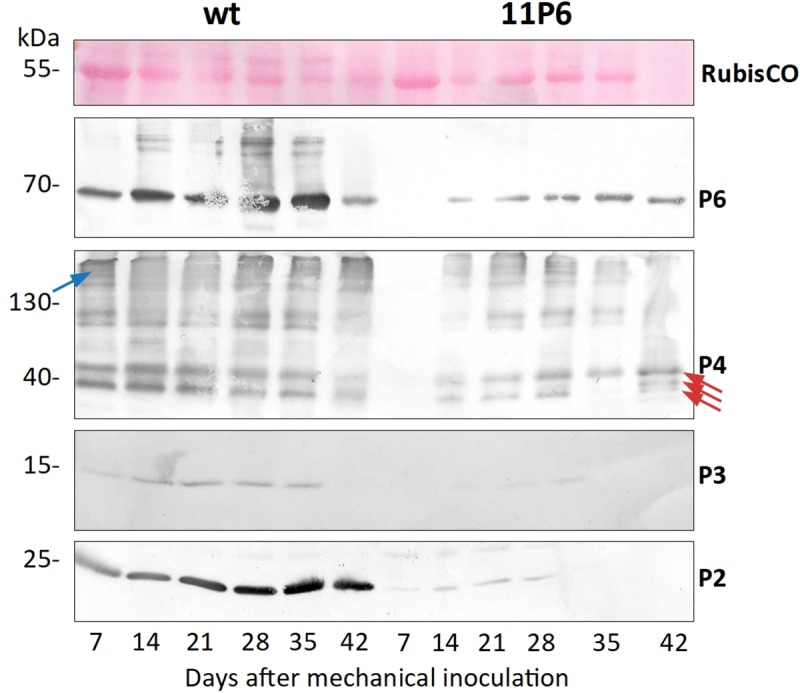
Kinetics of viral protein accumulation in turnip leaves.Total extracts of samples taken from the same systemically infected leaf at the time points indicated were analyzed by Western blotting with antisera against P2, P3, P4 or P6 (indicated by red arrows). The first panel (RuBisCO) shows a loading control (Ponceau Red staining of the large chain RuBisCO subunit). It should be noted that under the electrophoresis conditions used, much of the capsid protein P4 did not enter the gel properly and was retained in the upper part of the gels (blue arrow). The three red arrows in the anti-P4 blot point to the various mature P4 forms detected in infected plants [25]. Shown are the representative Western blots from one experiment out of seven performed.